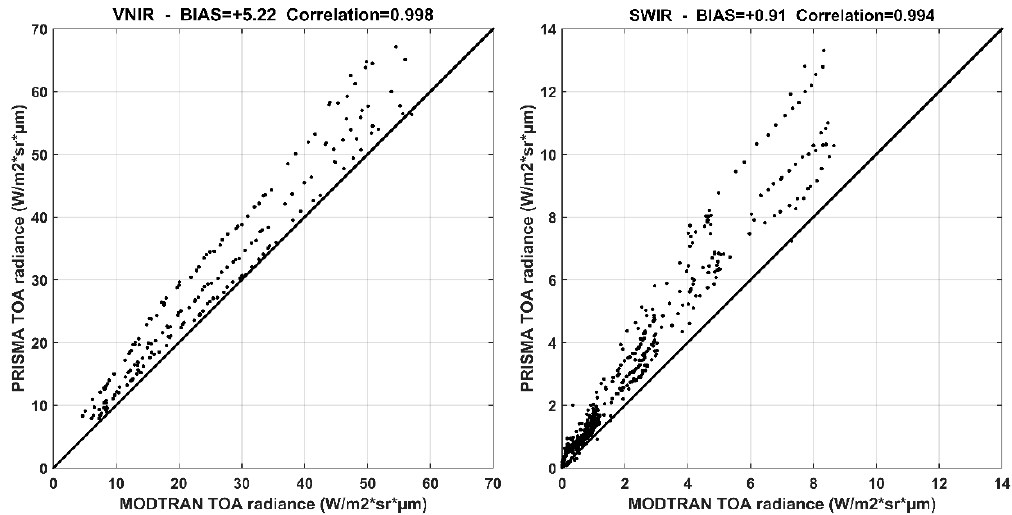
Figure 6. Scatter plots of radiance values for VNIR (on left ) and SWIR (on right ) considering all three days’ data.